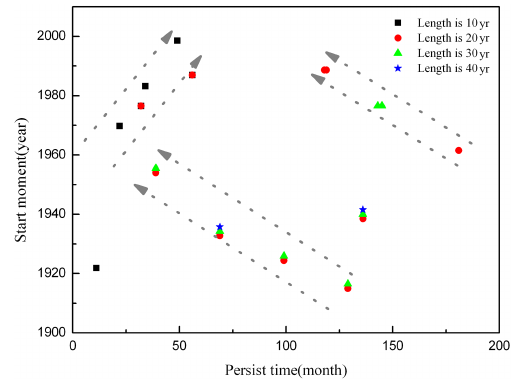
Figure 10. Abrupt changes start at different moments than their per- sist times. The x axis refers to the persist time of each abrupt change process, and the y axis refers to the start